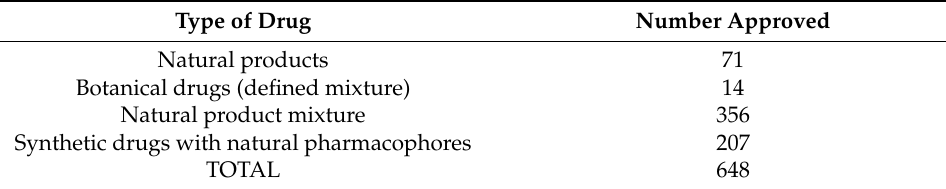
Table 1. Drugs approved by the FDA between 1 January 1981 and 30 September 2019 that were either derived from botanical drugs, unaltered natural products, or synthetic drugs with natural pharmacophore. Type of Drug Number Approved Natural products 71 Botanical drugs (defined mixture) 14 Natural product mixture 356 Synthetic drugs with natural pharmacophores 207 TOTAL